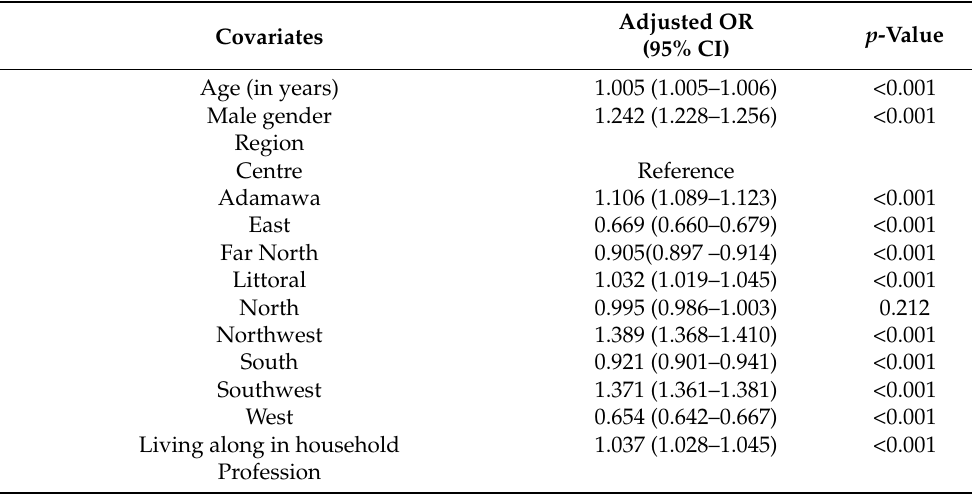
Table 5. Ordinal logistic regression investigating factors associated with adherence score, with standard errors clustered according to week of